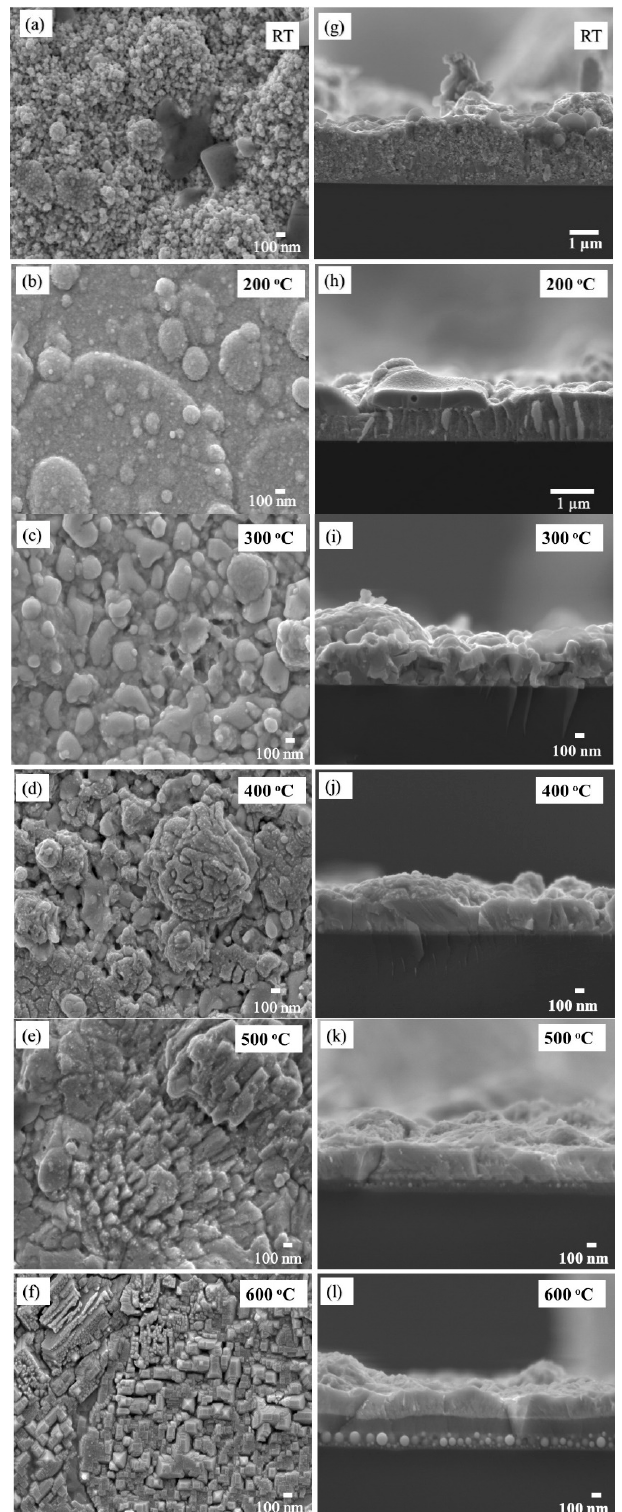
Figure 3. FESEM images ( a – f ) and cross ‐ sections ( g – l ) of Bi 2 O 3 :Ho 3+ thin films deposited at different substrate temperatures.